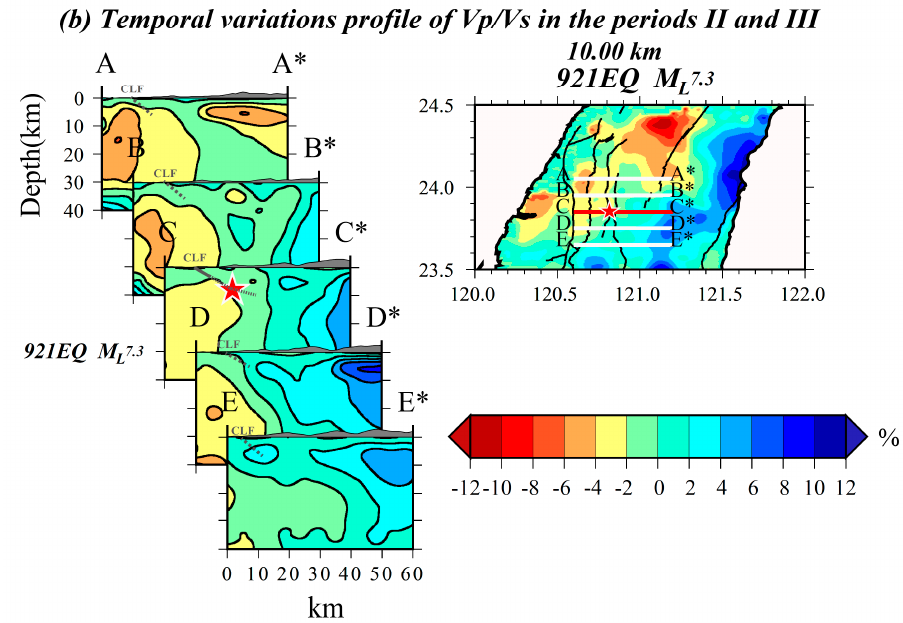
Figure 13. The AA* to EE* profiles analyzed in this study are displayed in the left panel. The profile across the Chi-Chi earthquake uses gray dotted line and red star to indicate the location of the CLF and the mainshock, respectively. The right panel shows the location of the AA* to EE* profiles. The profile CC* across the Chi-Chi earthquake are depicted with the thick red line. ( a ) Temporal variation profile of Vs in the periods II and III. ( b ) Temporal variation profile of Vp/Vs in the periods II and